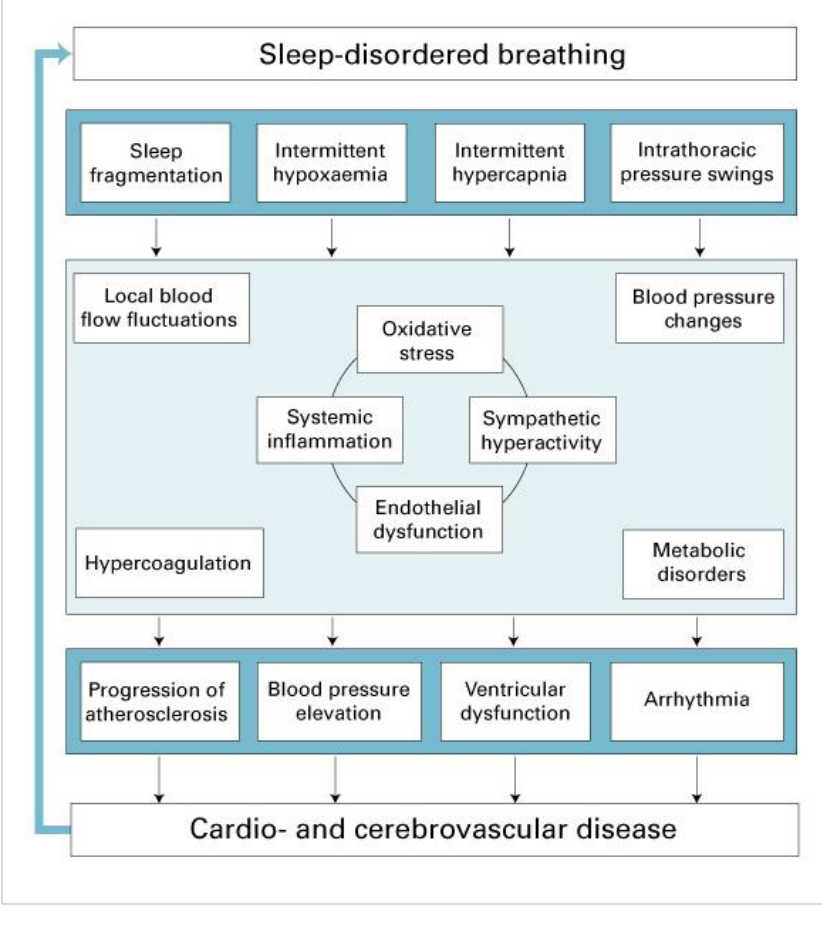
Figure 1: Overview of SDB-spe- cific pathophysiological mecha- nisms linking SDB with cerebro- and cardiovascular morbidity – a bidirectional